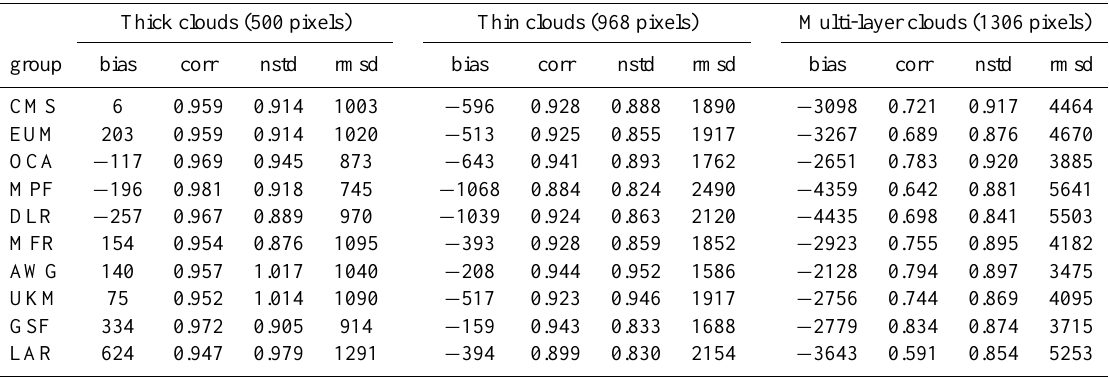
Table 9. Same as Table 6, but for three cloud regimes: thick, thin and multi-layer clouds. For multi-layer clouds the statistics are given with respect to the uppermost cloud layer. The mean CTHs observed by CALIOP are 4000, 5496 and 11014m and the standard deviations are 3497, 4784 and 4461m for thick, thin and multi-layer clouds, respectively.